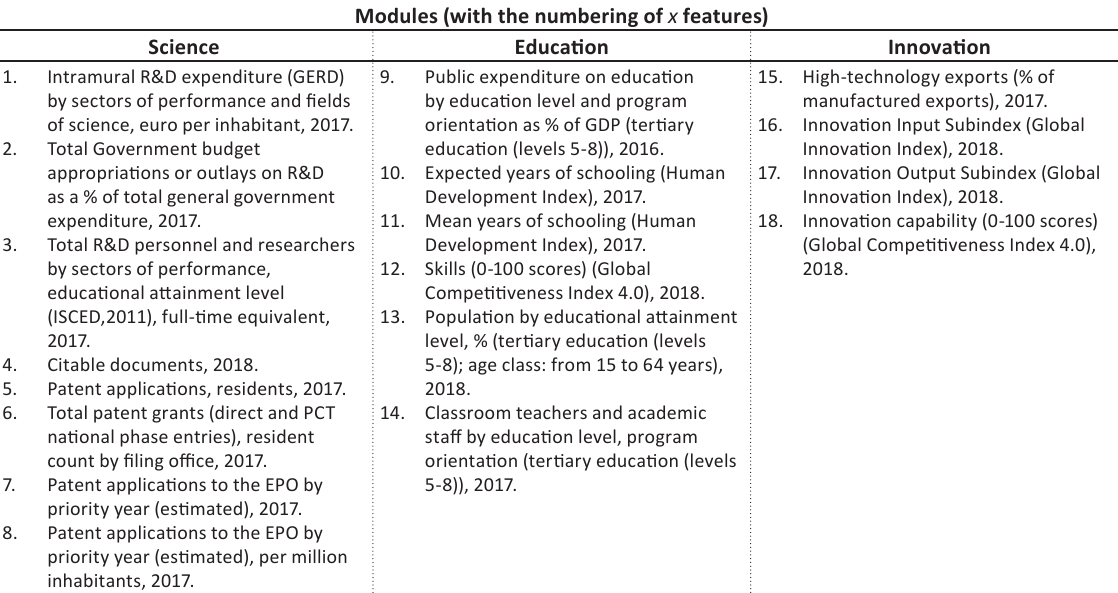
Table 1. A feature vector of the EU countries’ NISs, structuring its parameters according to the three main